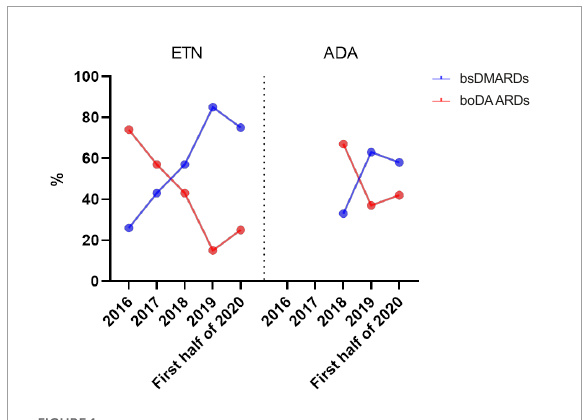
FIGURE1 Evolution of bsDMARD and boDMARD prescriptions over time.